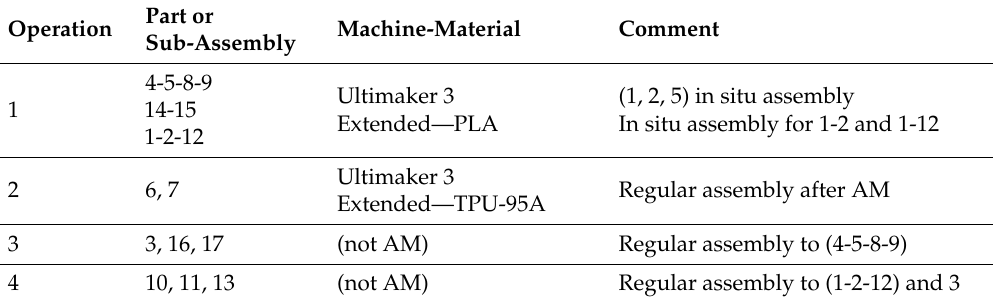
Table 4. Manufacturing plan.